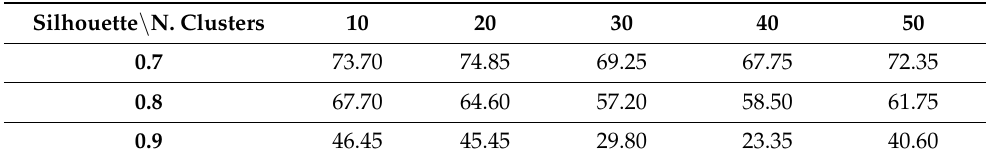
Table 36. Clustering performance in terms of silhouettes using the reduced dataset with SPQR applied to normalized data.